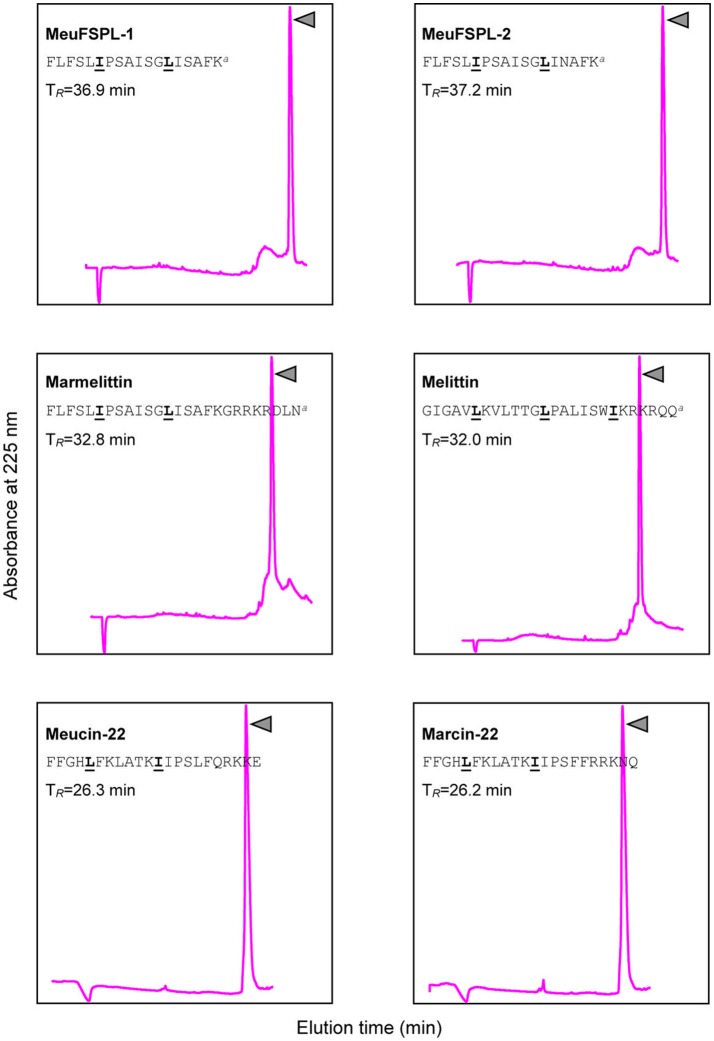
Purification of synthetic svAMPs by RP-HPLC. For each peptide, their sequences and retention times (TR) are shown. Pure peptides indicated by triangle were collected for structural and funtional studies. The leucine/isoleucine residues presumably forming a short leucine zipper-like motif are marked in bold and underlined once.